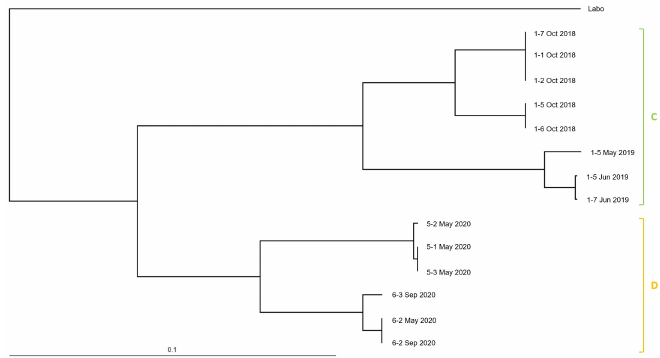
Figure 7. Dendrogram obtained using UPGMA (unweighted pair group method with arithmetic mean) among cohorts of Reticulitermes speratus collected in Isogi Park. Cohorts from the same population are labeled C and